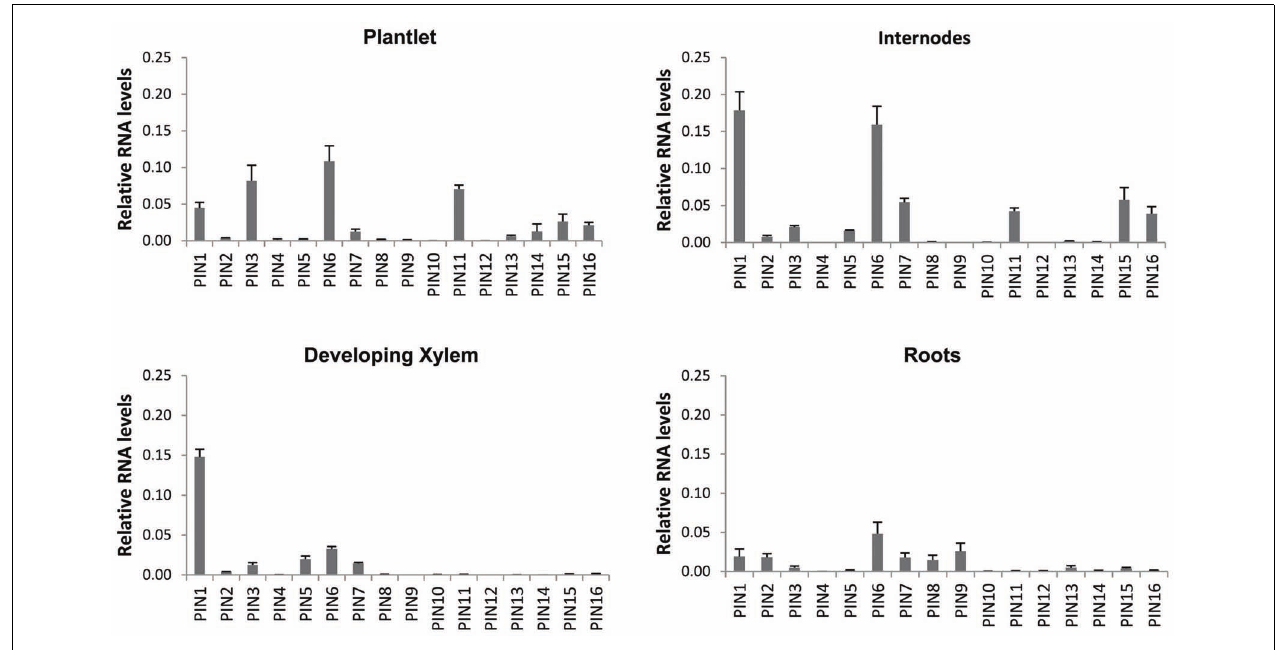
calculated via the 2 − ΔΔ Ct method (Livak and Schmittgen, 2001; Pfaffl, 2001) and baseline-corrected fluorescence values were normalized against the geometric mean of PtaPD-E1 , PtaTUA2 , PtaUBQ , PtaACT2. These reference genes were stably expressed across all tissues with the exception of developing xylem; this means that it is permissible to compare expression levels within any single tissue as well as across whole plantlets, internodes, and roots. Error bars represent the